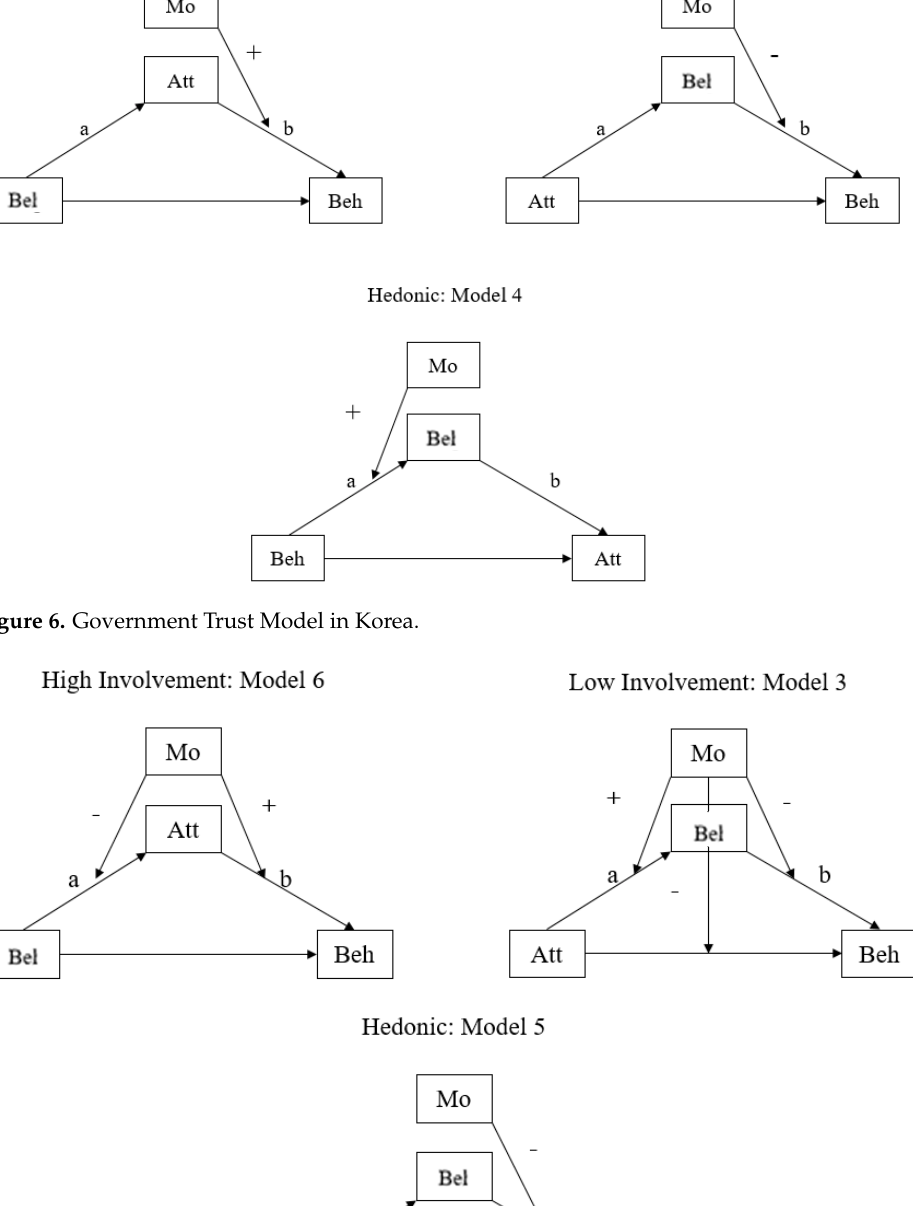
Figure 7. Government Trust Model in Japan.